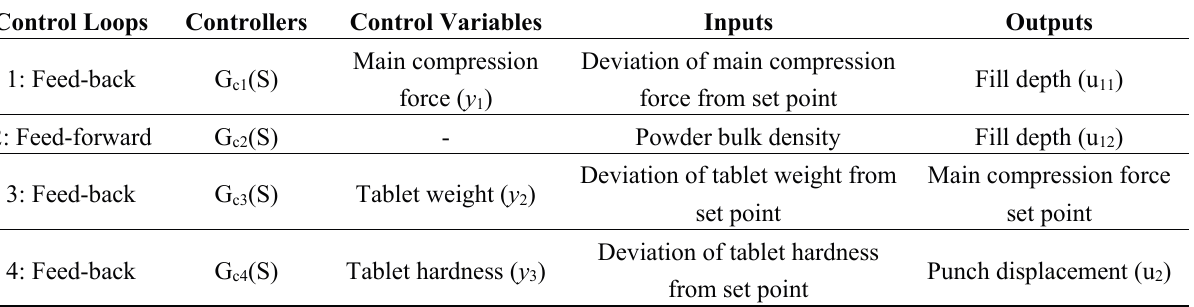
Table 2. Controller inputs and outputs.